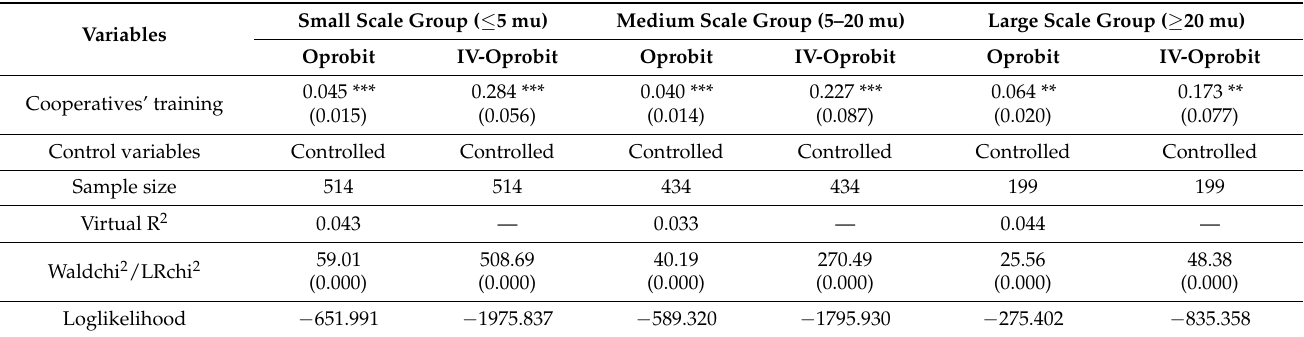
Table 4. Effect of cooperative training on the willingness of different generations of members’ willingness to adopt green production